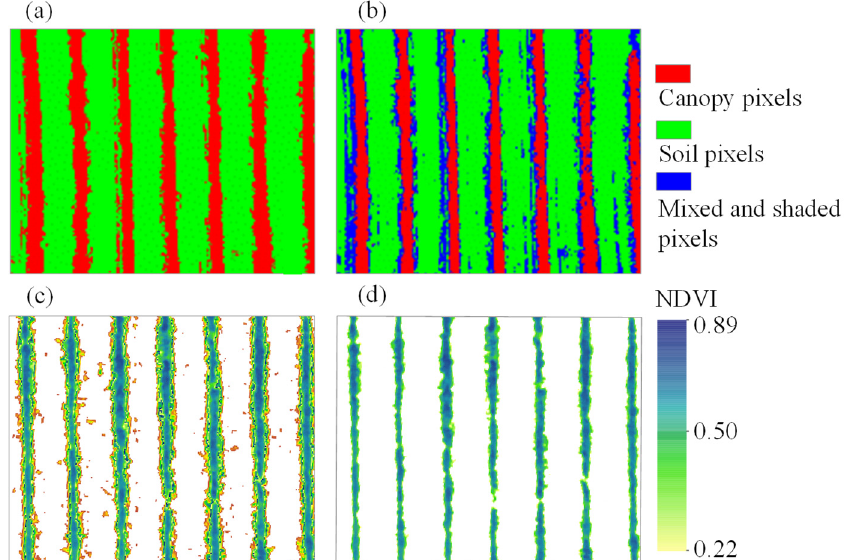
Figure 7. Example of spatial variability of four types of pixel classifications: ( a , b ) are the distribu- tions of not considering and considering the shaded soil based on supervised classification, respectively; ( c , d ) are the distributions of not considering and considering the shaded soil based on the supervised classification and normalized difference vegetation index (NDVI), respectively.